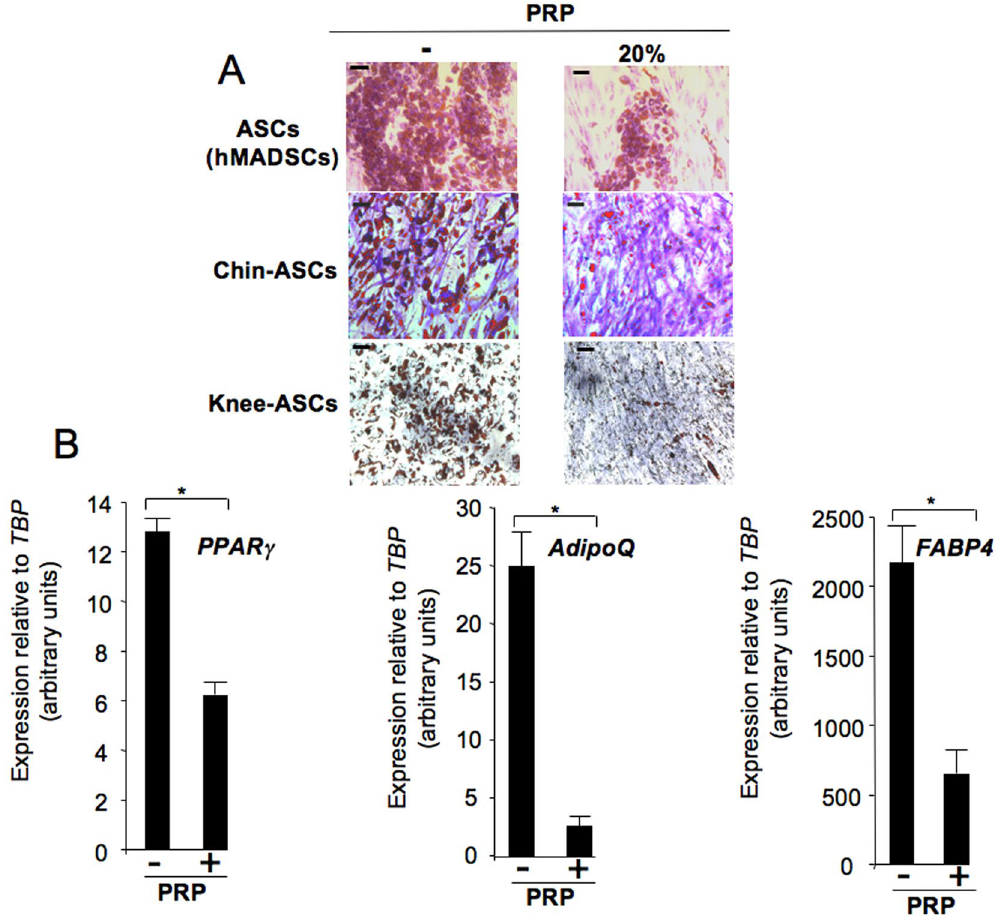
Figure 1. PRP inhibited ASC adipocyte differentiation. ( A ) ASCs (hMADScs), chin- and knee-ASC primary cultures were induced to undergo adipocyte differentiation in the absence ( − ) or presence ( + ) of 20% PRP. After 10 days, cells were fixed and stained with Oil Red O to visualize lipid droplets, then with nonspecific violet crystals to stain the cell layer. Bar scale: 50 μ m. ( B ) ASCs were maintained as in ( A ) and RNAs were prepared to analyse expression of the indicated genes by real-time PCR. Values are means ± SEM (n = 3 individual PRPs). * p <